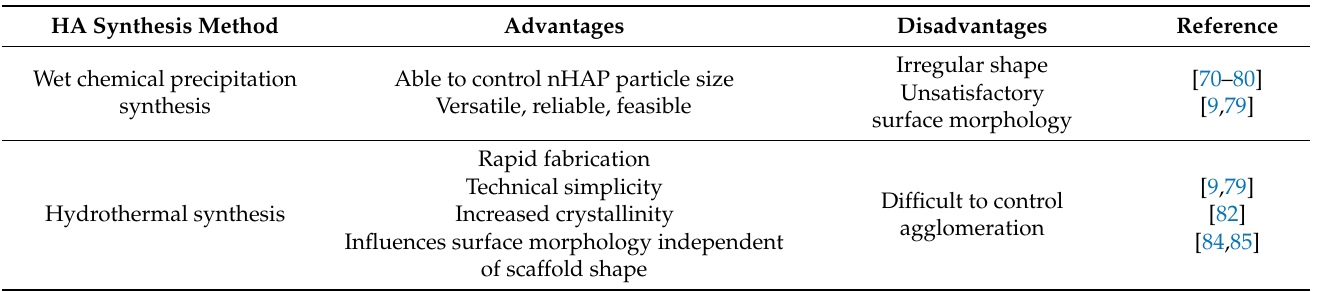
Table 2. Hydroxyapatite synthesis methods: advantages and